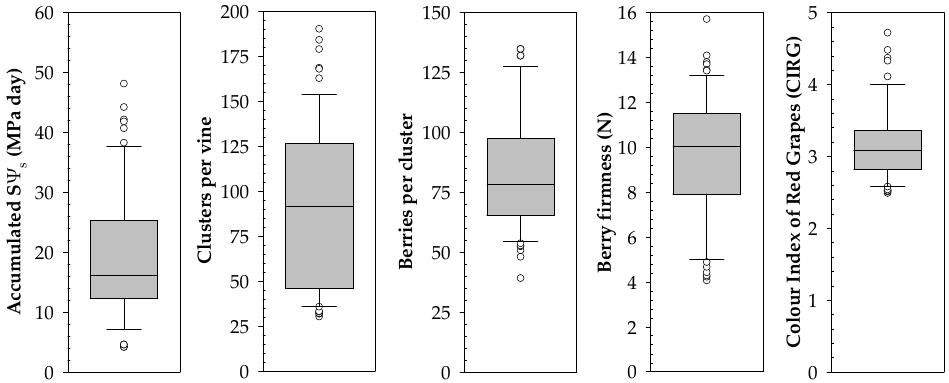
Figure 4. Box-and-whisker plots of the variables used to elaborate the predictive models. n = 67 for all the variables, except n = 64 for CIRG.